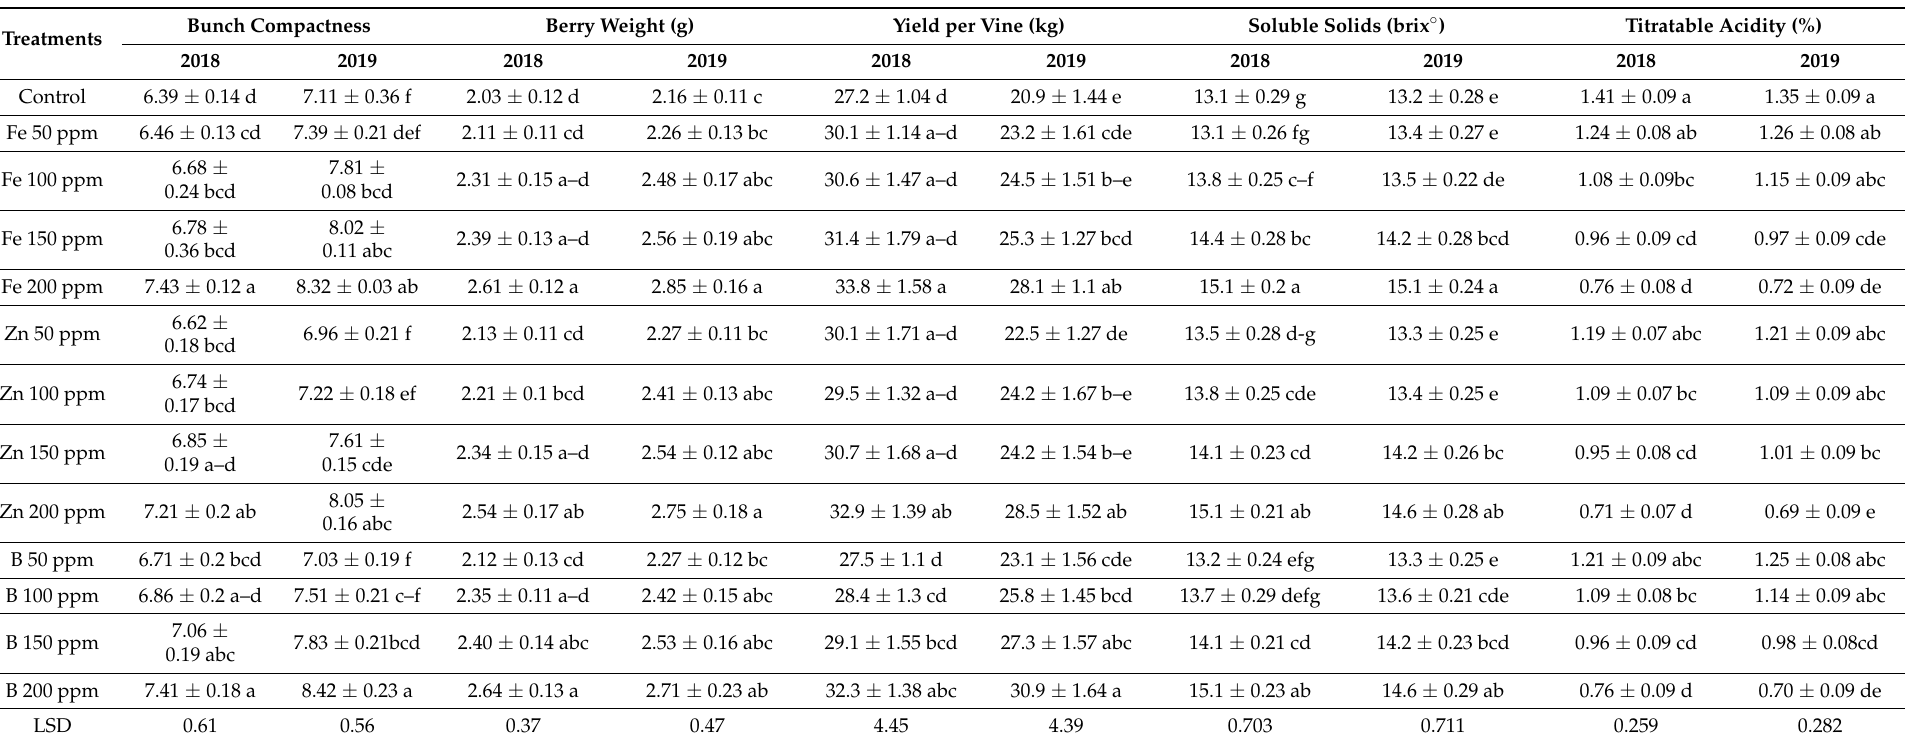
Table 3. Effect of foliar application of micronutrients on different yield and quality characteristics of grapes cv. ‘Flame Seedless’ during the years 2018 and 2019. Bunch Compactness Berry Weight (g) Yield per Vine (kg) Soluble Solids (brix ◦ ) Titratable Acidity Treatments